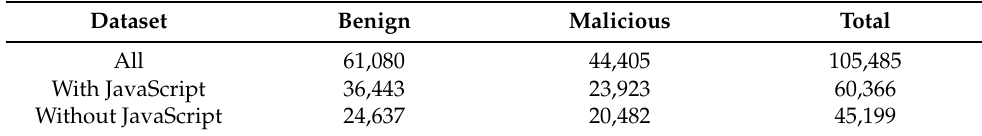
Table 2. Dataset